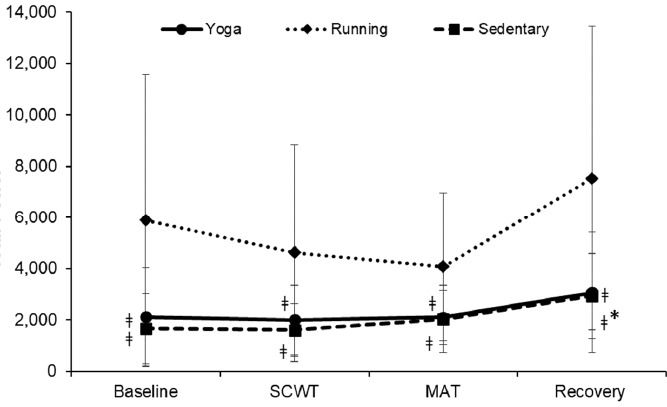
cantly greater in the running group when compared to that of the other two groups (all p